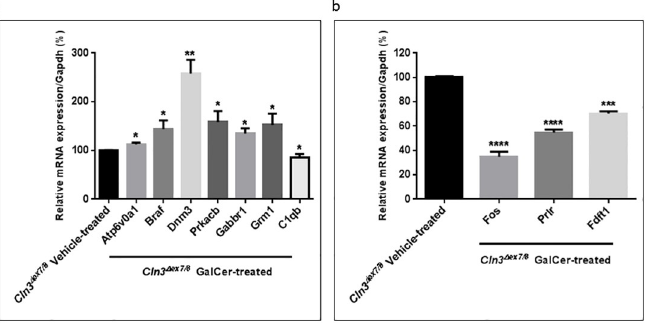
Fig 8. Validation of microarray analysis results with qRT-PCR in male and female Cln3 Δ ex7/8 mouse brain. Relative mRNA expression measured by qRT-PCR. (a) The following differentially expressed genes in male Cln3 Δ ex7/8 mouse brains were randomly chosen: Atp6v0a1 , Braf , Dnm3 , Prkacb , Gabbr , Grm1 , and C1qb . Values are means of the fold changes normalized to Gapdh mRNA expression, with standard errors represented by vertical bars. � p- value < 0.05 and �� p-value < 0.01 by Student’s t -test (n = 4). (b) The following differentially expressed genes in female Cln3 Δ ex7/8 mouse brains were randomly chosen: Fos , Prlr , and Fdft1 . Values are means of the fold changes normalized to Gapdh mRNA expression, with standard errors represented by vertical bars. ��� p-value < 0.001 and ���� p- value < 0.0001 by Student’s t -test (n =